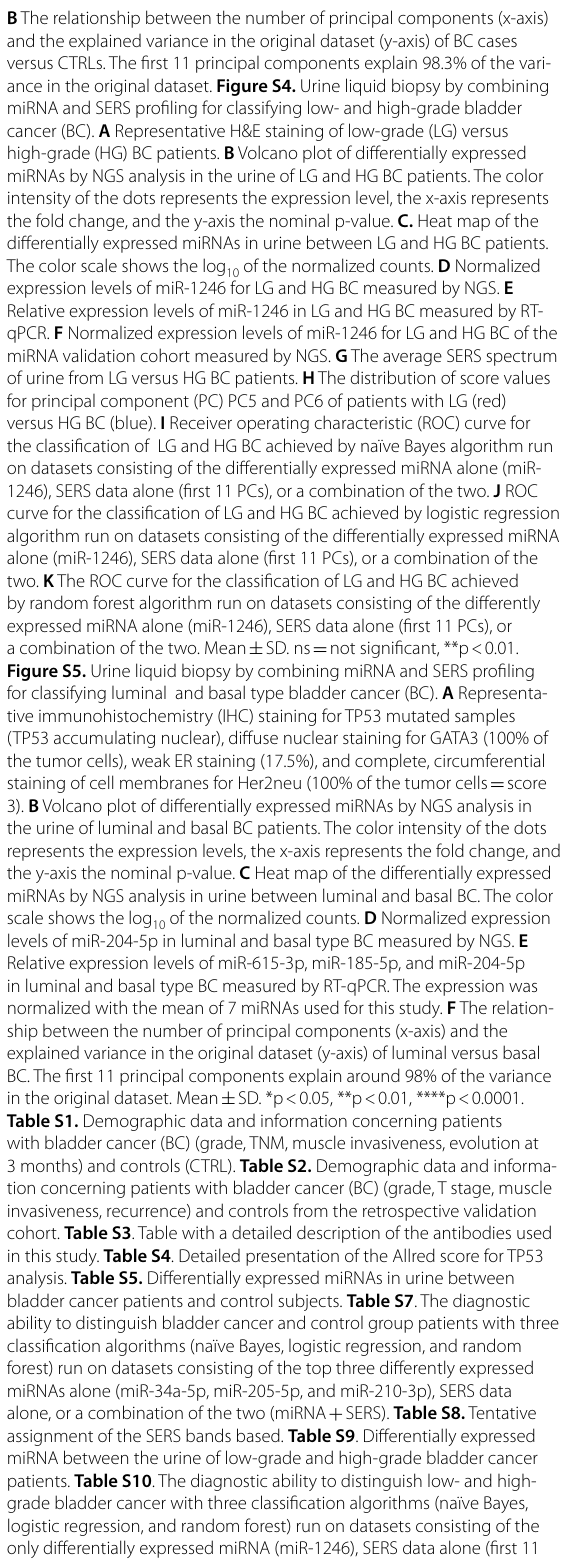
cohort. Table S3 . Table with a detailed description of the antibodies used in this study. Table S4 . Detailed presentation of the Allred score for TP53 analysis. Table S5. Differentially expressed miRNAs in urine between bladder cancer patients and control subjects. Table S7 . The diagnostic ability to distinguish bladder cancer and control group patients with three classification algorithms (naïve Bayes, logistic regression, and random forest) run on datasets consisting of the top three differently expressed miRNAs alone (miR-34a-5p, miR-205-5p, and miR-210-3p), SERS data alone, or a combination of the two (miRNA SERS). Table S8. Tentative + assignment of the SERS bands based. Table S9 . Differentially expressed miRNA between the urine of low-grade and high-grade bladder cancer patients. Table S10 . The diagnostic ability to distinguish low- and high- grade bladder cancer with three classification algorithms (naïve Bayes, logistic regression, and random forest) run on datasets consisting of the only differentially expressed miRNA (miR-1246), SERS data alone (first